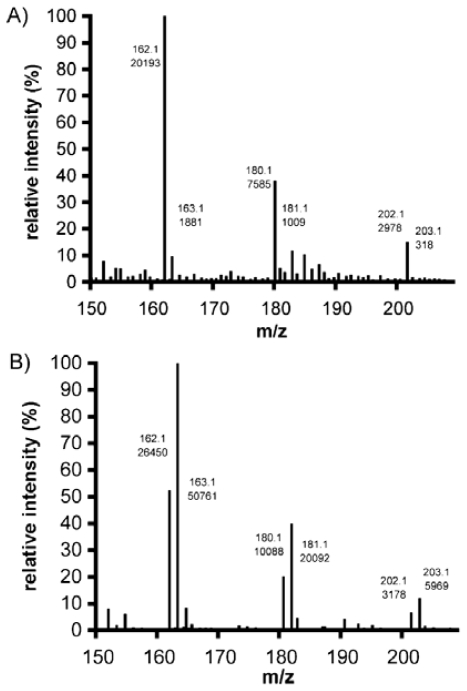
Mass spectra of acid hydrolyzed chitin from P. chrysogenum growing on (A) minimal medium, (B) medium with the addition of (15NH4)2SO4 (rich medium–Blakeslee’s formula). Reprinted with permission from Biomacromolecules. 2009, 10, 793–797. Copyright 2010, American Chemical Society [245].